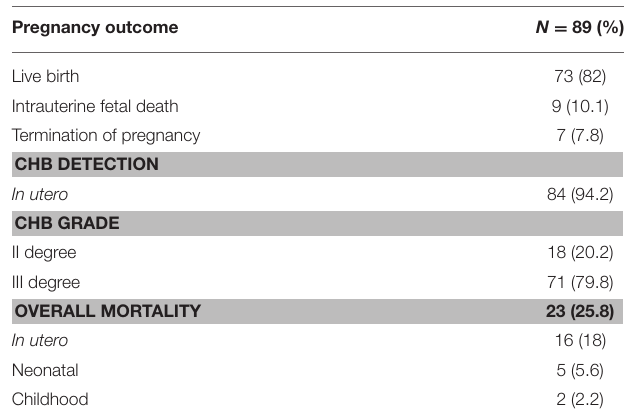
TABLE 3 | Outcomes of 89 cases of